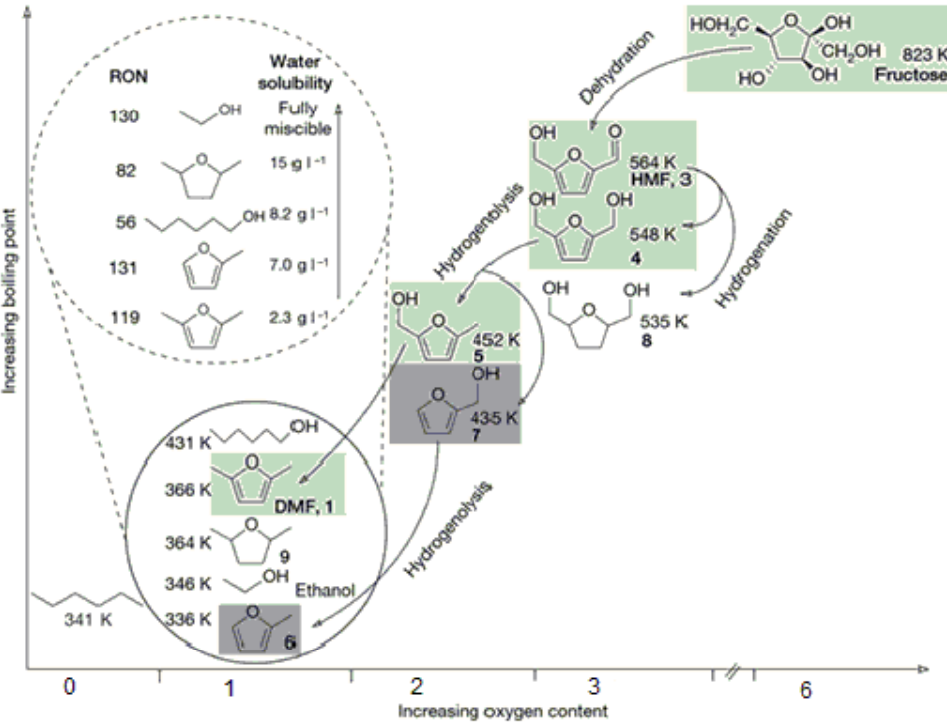
Figure 2. Normal boiling points of representative C6 hydrocarbons formed by removal of oxygen atoms from hexoses compared to the normal boiling point of ethanol. Adapted from [13].